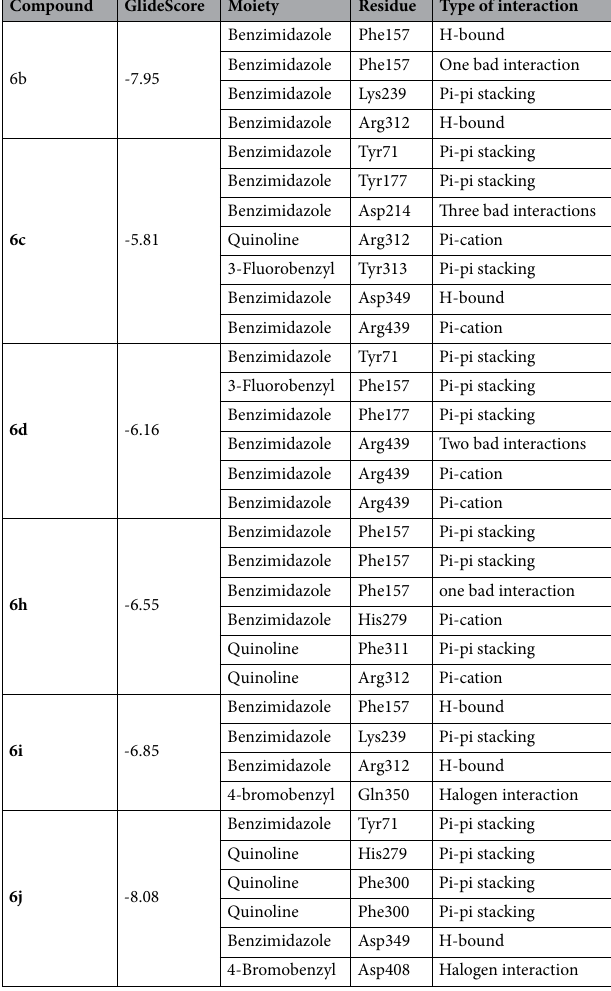
Table 2. The predicted binding energy of all derivatives with the desired enzyme.